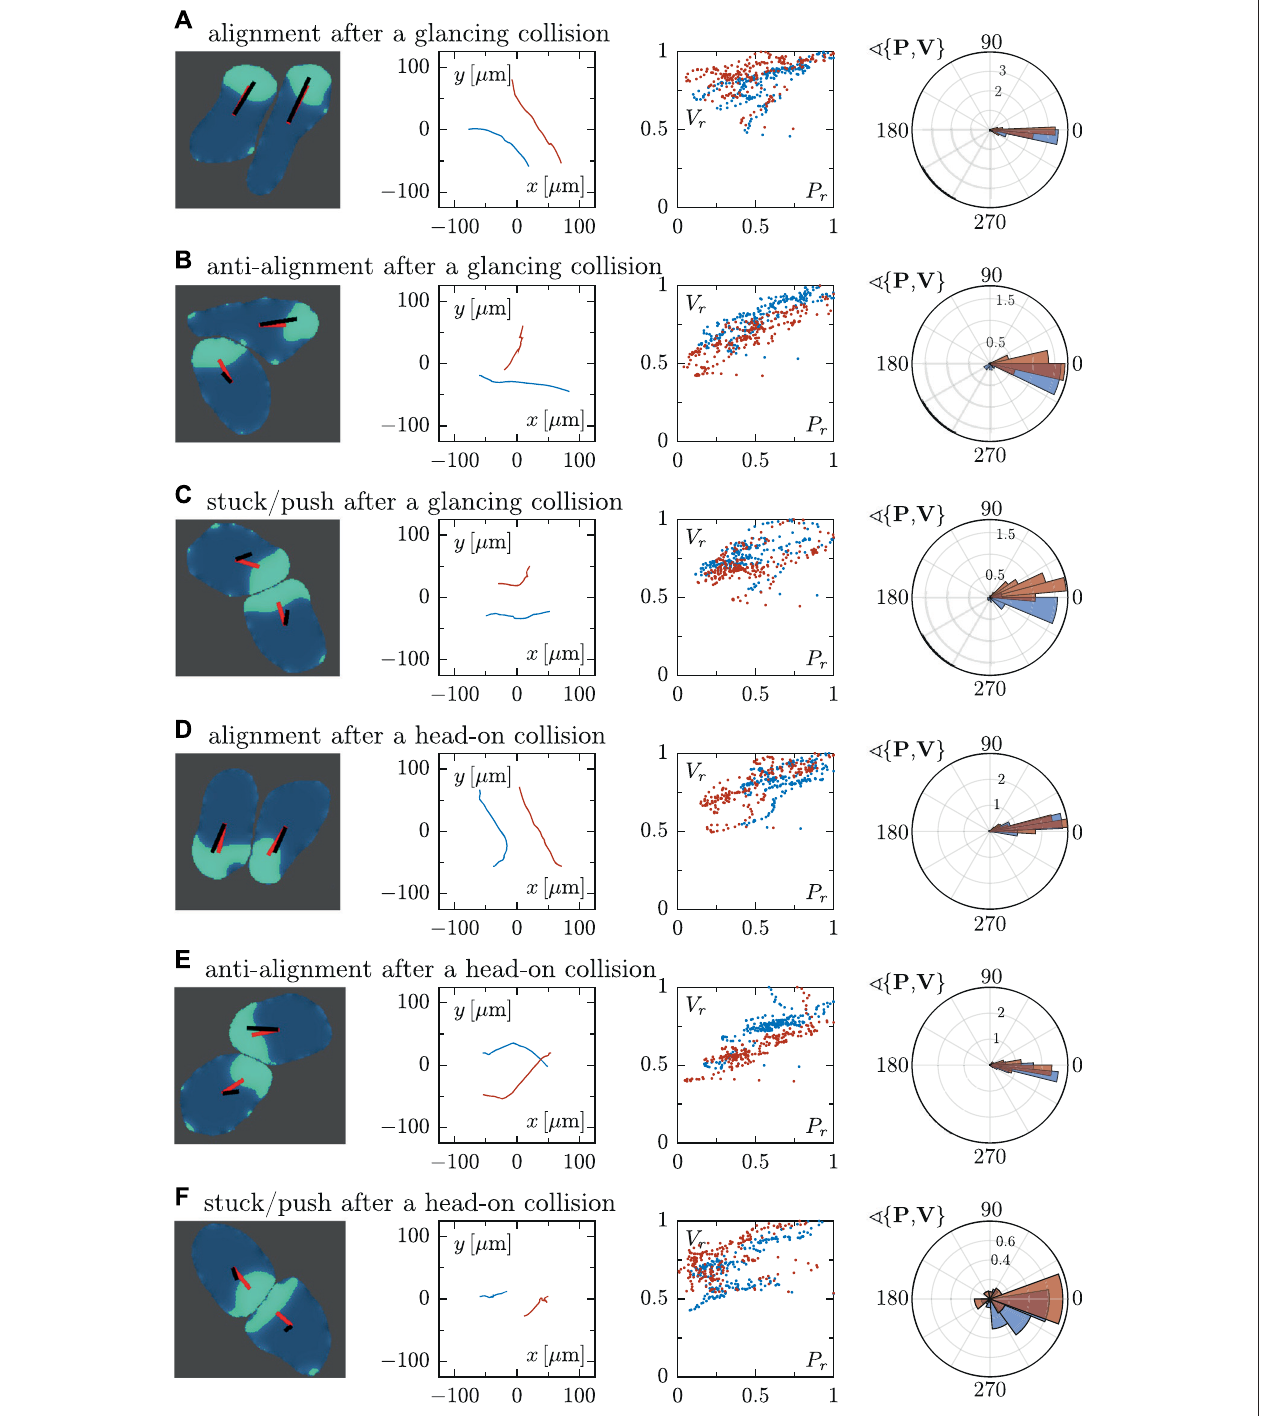
FIGURE 6| Quantitative analysis ofbinary cell interactionsin terms ofthe cell polarity and velocity vectors for different interaction scenarios, cf. Figure 5 . For every row (A – F) , the fi rst column panels show the snapshots of cells where a representation of the vectors P and V is included. The second column shows the corresponding trajectories.Analogouslyto Figure3 ,thethirdcolumnrepresents thecorrelation oftherescaled magnitudesofvectors P and V ofthetwointeractingcells.Thepanelsin the fourth column show circular histograms of the angle θ enclosed by cell polarity P and velocity V . The collision scenarios in (A – C) correspond to glancing collisions,resultingin (A) alignment, (B) anti-alignmentand (C) stuck/pushcon fi gurations.Incontrast,panels (D – F) correspondtohead-oncollisions,likewiseresultingin (D) alignment, (E) anti-alignment and (F) stuck/push con fi gurations.